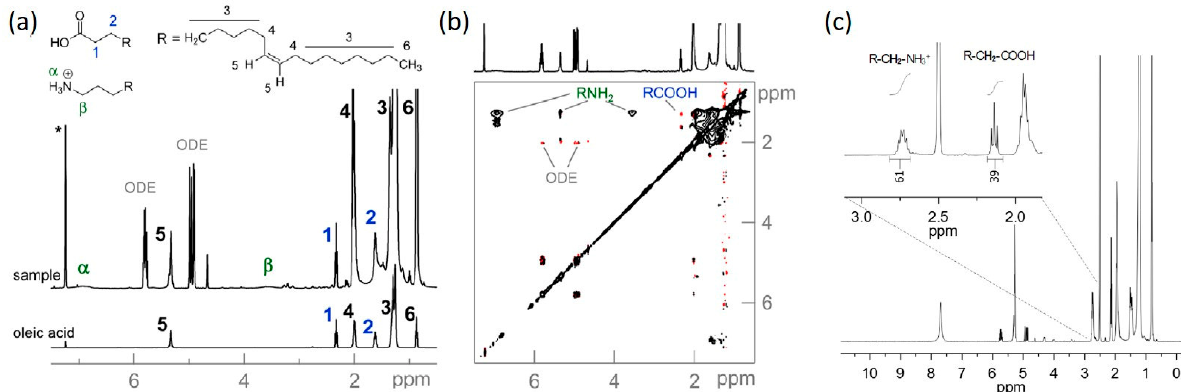
Figure 4. ( a ) 1 H NMR spectrum of CsPbBr 3 NCs (sample) and reference spectrum for oleic acid. ( b ) NOESY map of CsPbBr 3 NCs. Reprinted with permission from ref. [88]. Copyright 2016 American Chemical Society.; ( c ) 1 H NMR spectrum of Cs 4 PbBr 6 NCs dissolved in DMSO-d 6 after the addition of small amounts of protonating agent trifluoroacetic acid for quantification of the ratio between oleylamine and oleic acid. Reprinted with permission from ref. [94]. Copyright 2020 Royal Society of Chemistry.